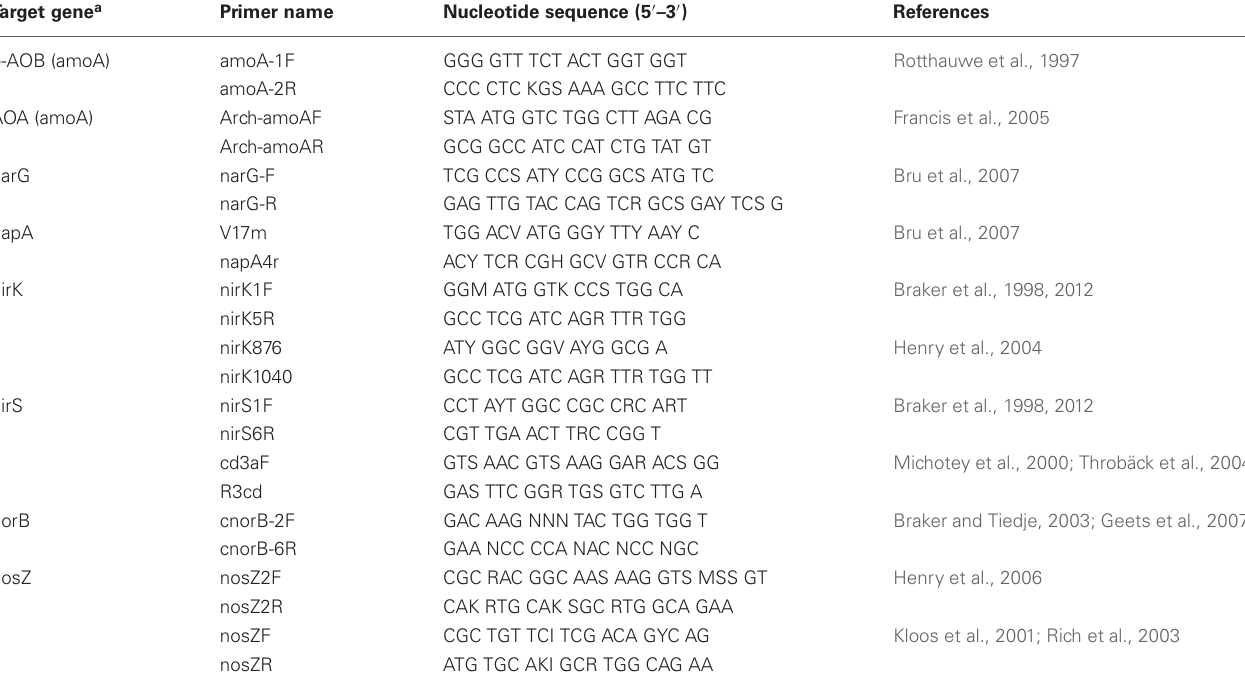
Table 4 | Reported primers and literature references relevant for NO and N 2 O turnover during N-cycling. Target gene